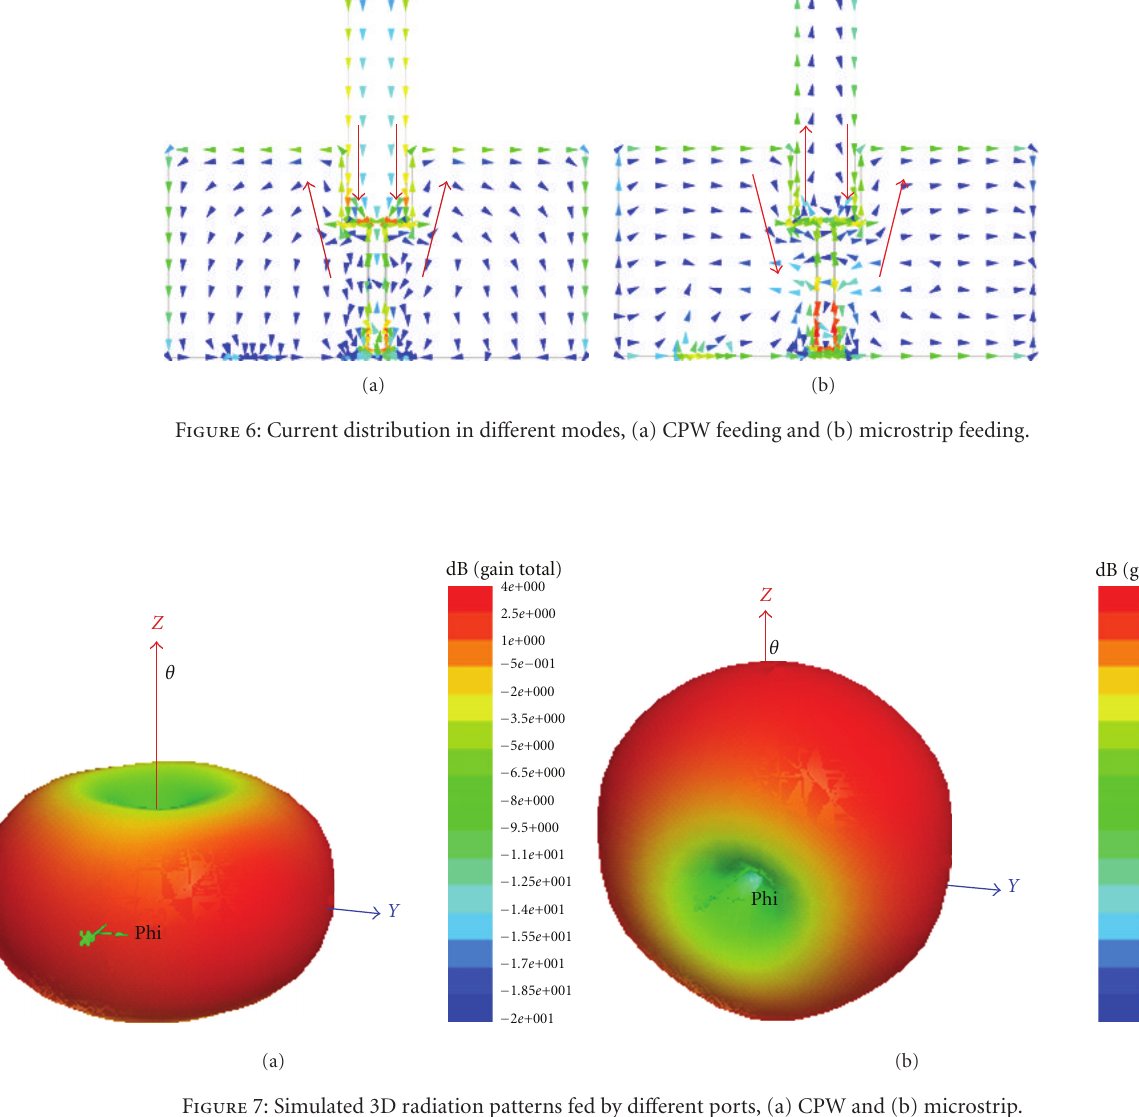
Figure 7: Simulated 3D radiation patterns fed by di ff erent ports, (a) CPW and (b)